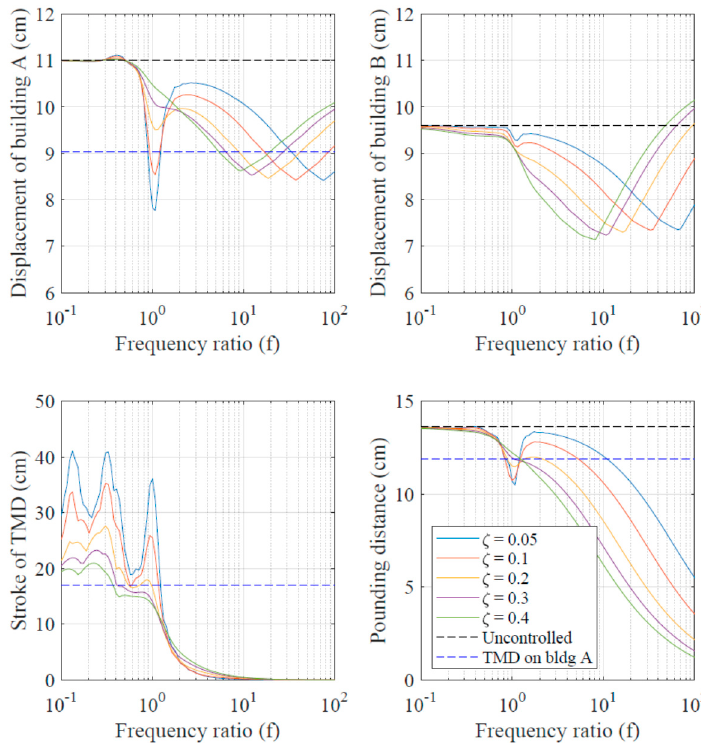
Figure 3. Peak displacement of building A, displacement of building B, stroke of the TMD, and minimum separation.